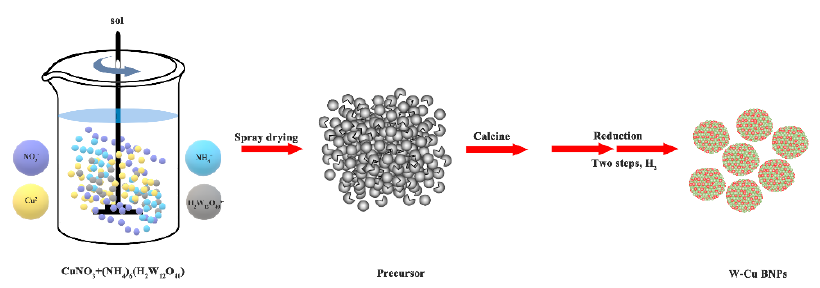
Figure 1. Synthesis schematic of W–Cu BNPs via a nano in situ composite